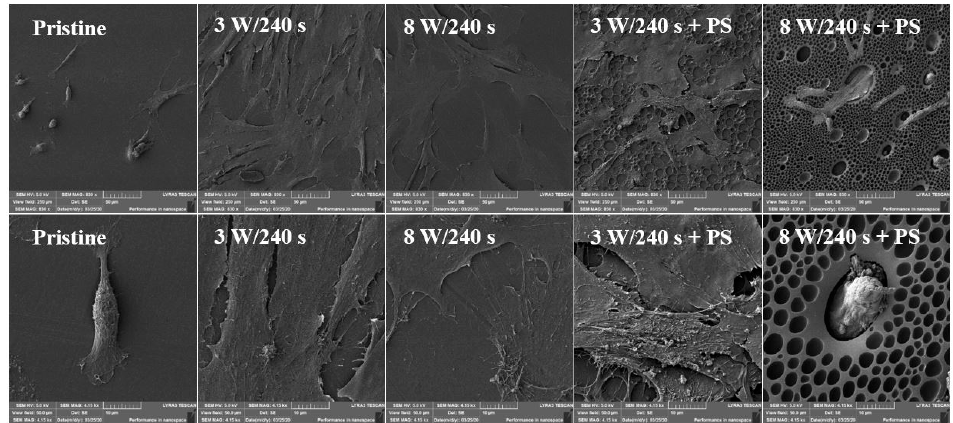
Figure 15. Scanning electron microscopy images of primary human fibroblasts (MRC-5) at 6 days post-seeding on FEP (pristine), FEP matrices treated using plasma with 3 W and 8 W (240 s) and subsequently coated with a honeycomb-like pattern formed from PS. The upper line represents a 250 × 250 µm 2 scan, the bottom line a detailed scan with an area of 30 × 30 µm 2 .